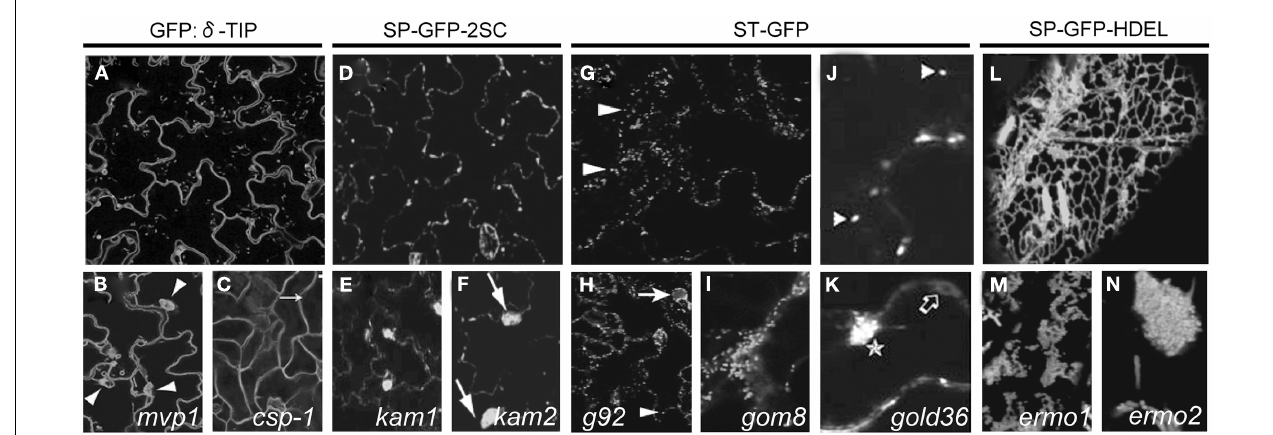
spots correspond to Golgi stacks (arrowheads). Adapted from Faso et al. (2009) and Marti et al. (2010). Mutant g92 (H) showing additional to Golgi (M) and ermo2 (N) revealing a number of strongly GFP-labeled spherical structures. Adapted from Nakano et al.